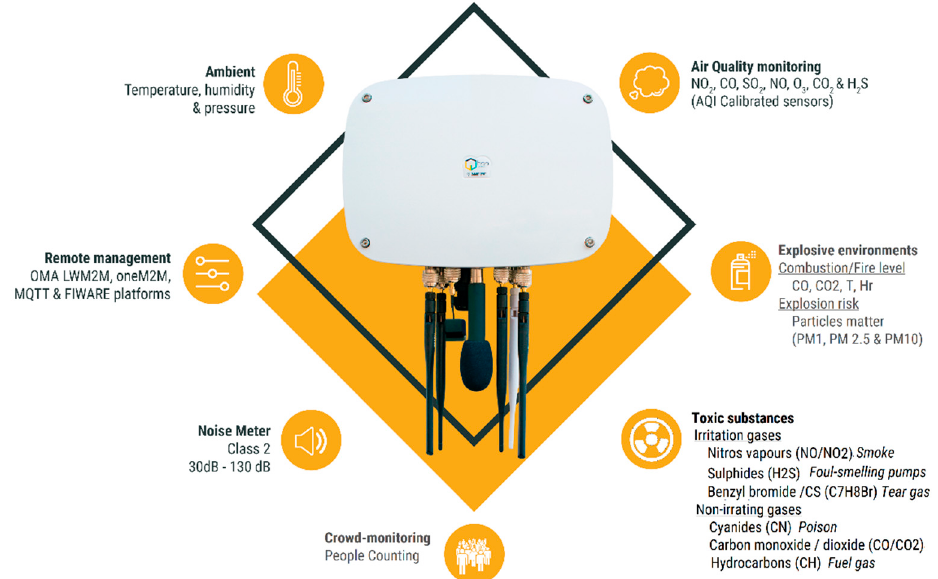
Figure 2. HOPU Smart Spot IoT device (HOPU Smart Spot IoT device offers Open Source libraries and framework for research purposes, smart cities and smart destination projects. Please contact: